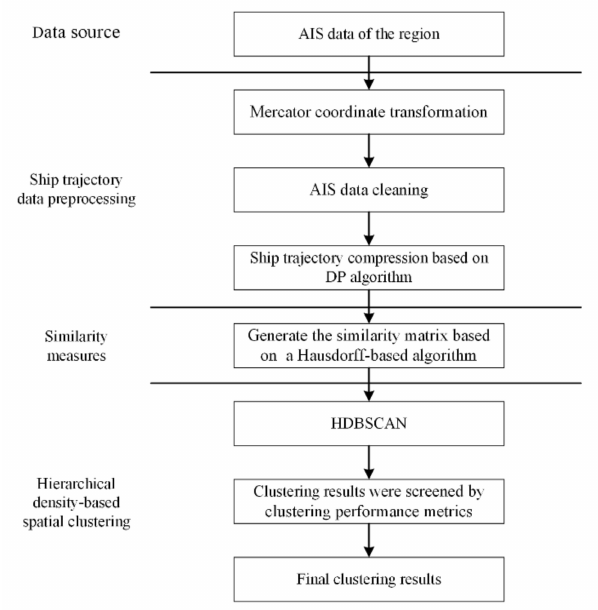
Figure 1. Methodological overview of the